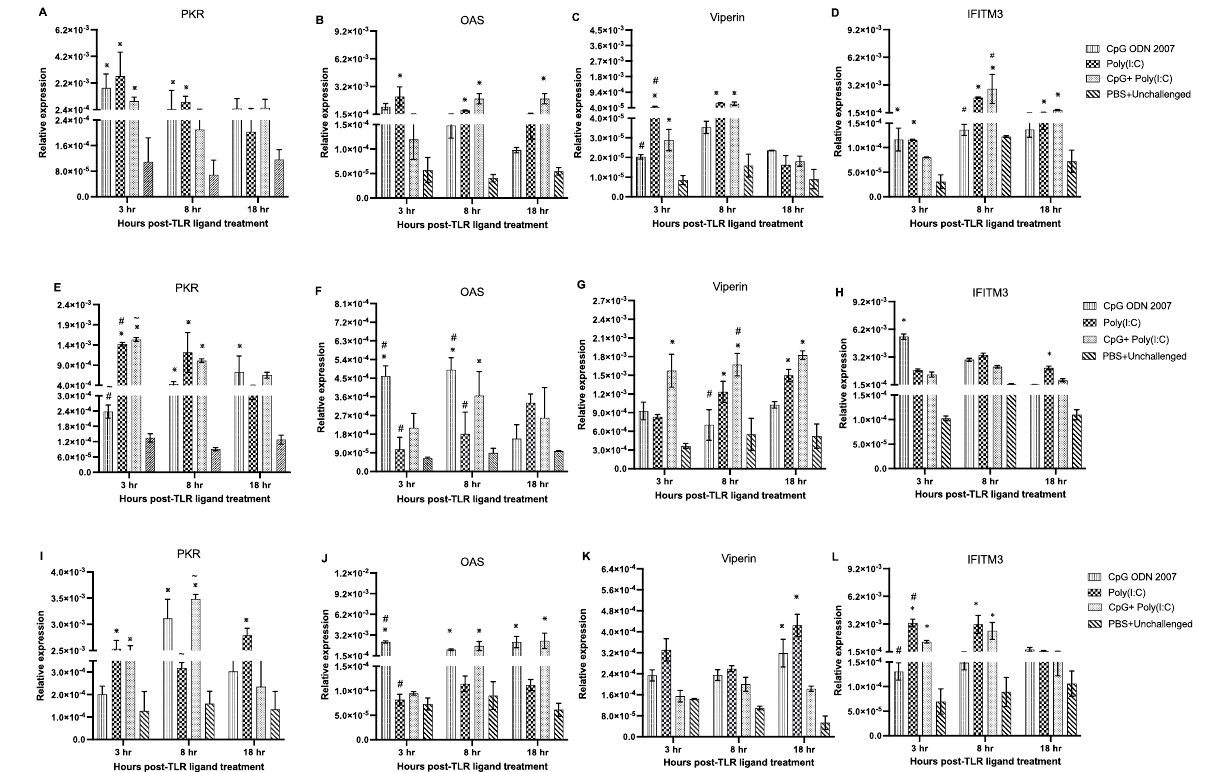
Figure 7. Relative gene expression of IFN-α, IFN-β and IFN-γ in the duodenum ( A – C ), jejunum Figure 8. Relative gene expression of ISGs in the duodenum ( A – D ), jejunum ( E – H ) and ileum ( I – L ) at ( D – F ) and ileum ( G – I ) at 3, 8 and 18 h post-CpG ODN 2007, poly(I:C) and combination treatment. 3, 8, and 18 h post-CpG ODN 2007, poly(I:C) and CpG ODN 2007 + poly(I:C) administration. Relative Relative gene expression of IFN-α, IFN-β and IFN-γ at 3, 8 and 18 h post-TLR ligand treatment. gene expression of PKR, OAS, viperin and IFITM3 at 3, 8, and 18 h post-TLR treatment. Chickens Chickens were treated with CpG ODN 2007 (10 μg/chicken), poly(I:C) (400 μg/chicken) and a com- were treated with CpG ODN 2007 (10 µ g/chicken), poly(I:C) (400 µ g/chicken) and a combination of bination of CpG ODN 2007 (10 μg/chicken) + poly(I:C) (400 ug/chicken), or 100 μL PBS for the CpG ODN 2007 (10 µ g/chicken) + poly(I:C) (400 µ g/chicken), or 100 µ L PBS for the negative group. negative group. The plotted values represent the mean gene expression levels relative to B-actin ± The values represent the mean gene expression levels relative to B-actin ± standard error of the mean standard error of the mean (SEM). Statistical significance was calculated using one-way ANOVA (SEM). Statistical significance was calculated using one-way ANOVA followed by Tukey’s multiple followed by Tukey’s multiple comparison test. The results were considered significant from PBS control p < comparison test. The results were considered significant from PBS control p < 0.05